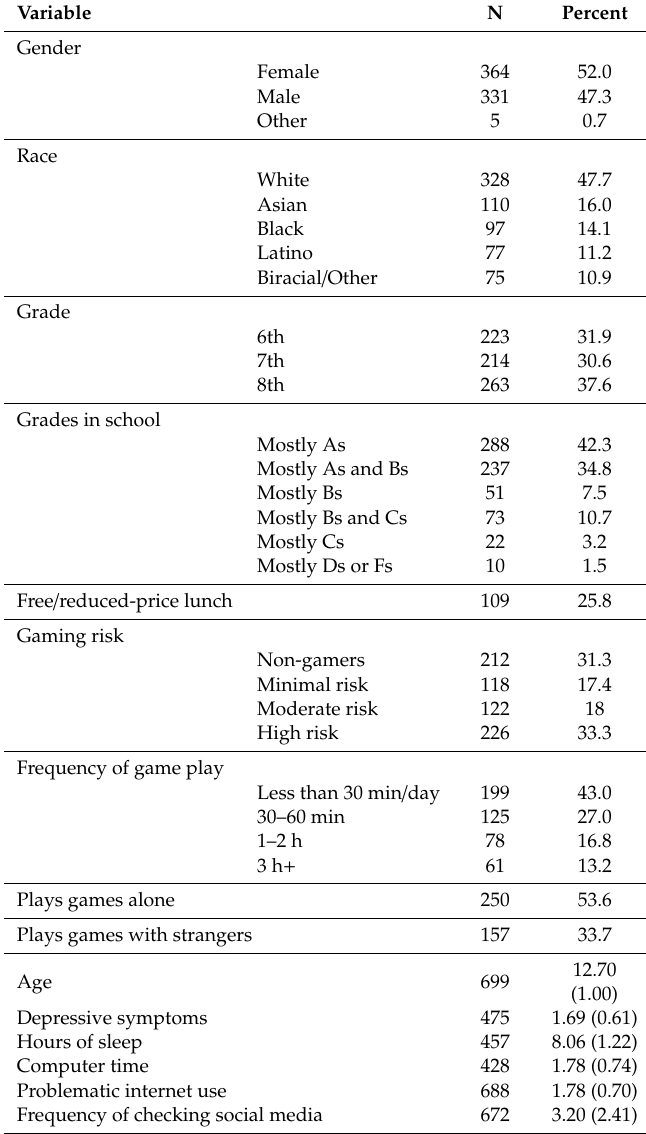
Table 1. Study 1: Sample